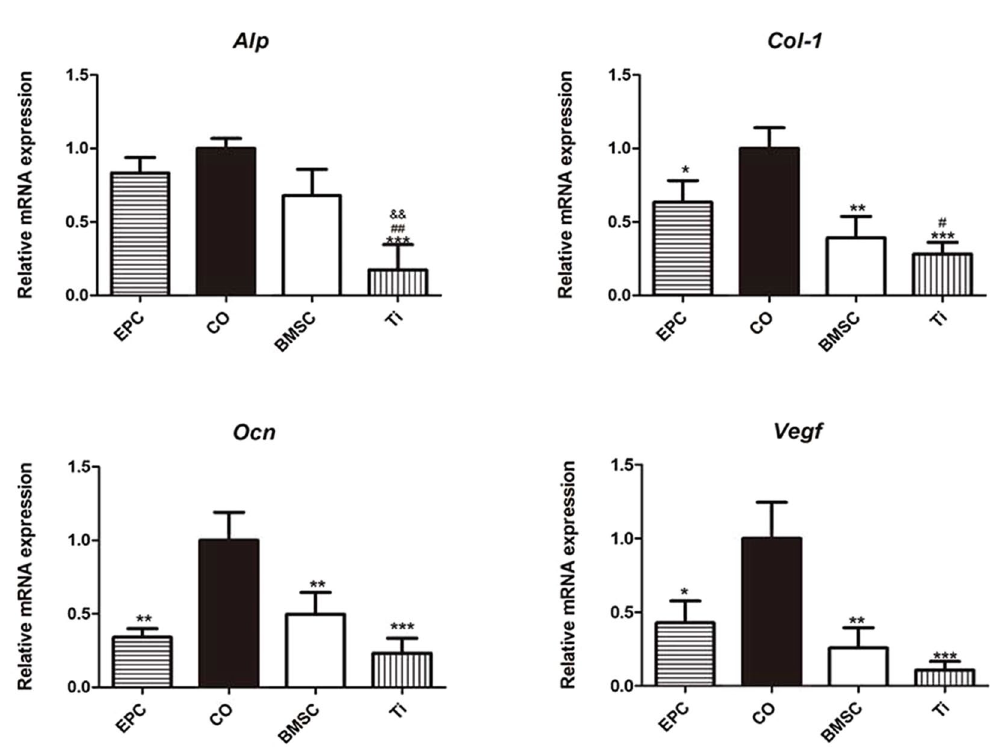
Figure 8. Gene expression of the bone fragments around implants in each group. * p < 0.05, ** p < 0.01, *** p < 0.001 vs CO, # p < 0.05, ## p < 0.01 vs EPC, && p < 0.01 vs